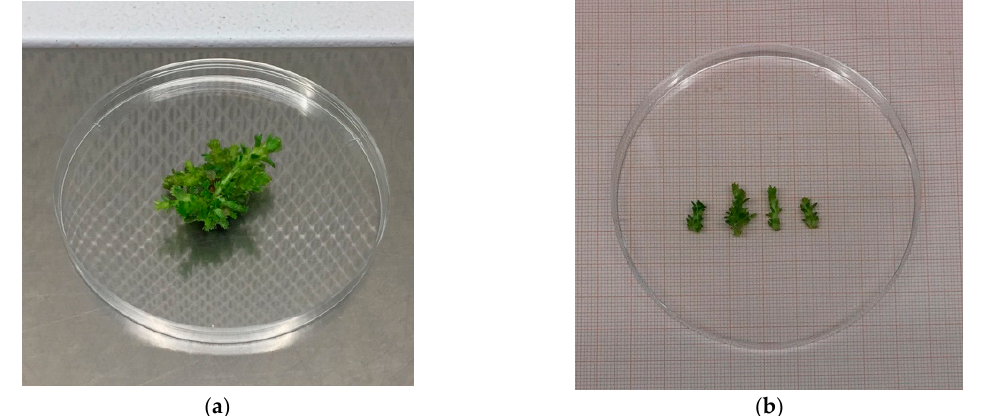
Figure 9. “ Sal 39” explant obtained in a solid medium after 60 days ( a ) and detail of the length of each